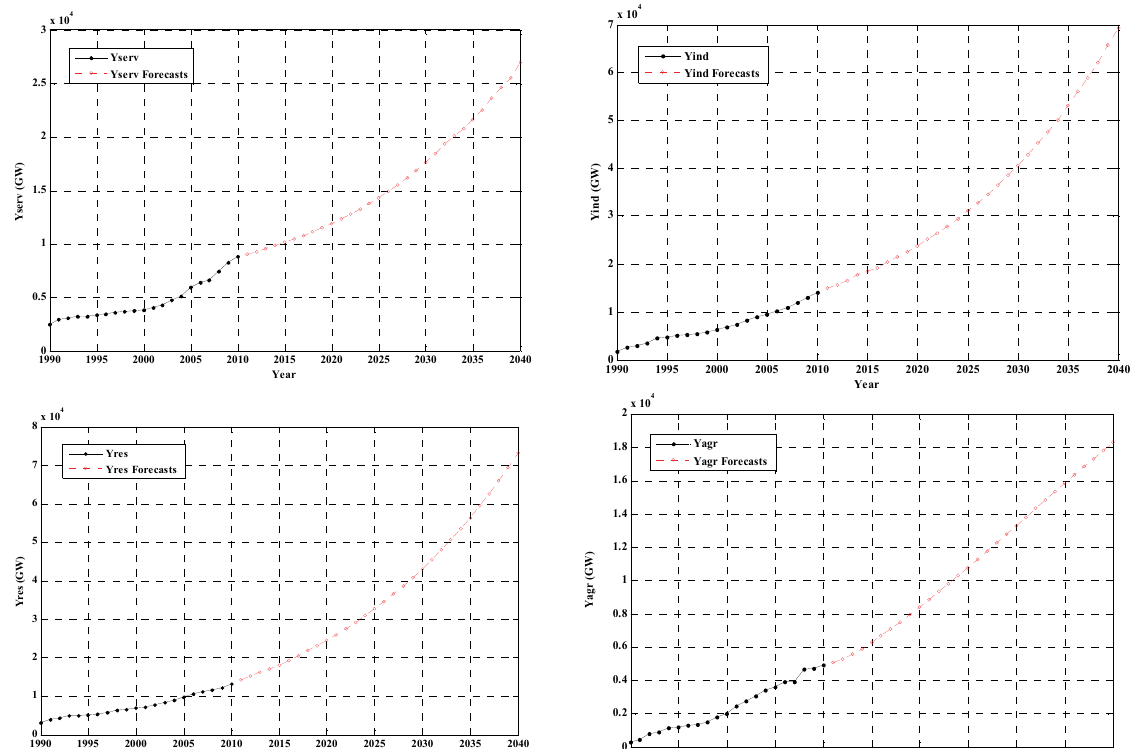
Fig. 2. Forecasts of Iran`s industrial, residential, services, and agriculture peak demand up to 2040 in business-as-usual